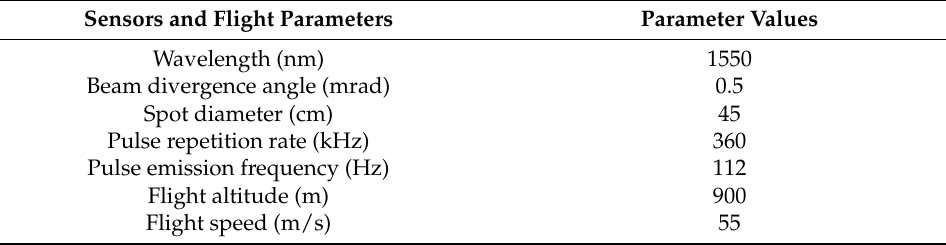
Table 2. LiDAR sensor and flight